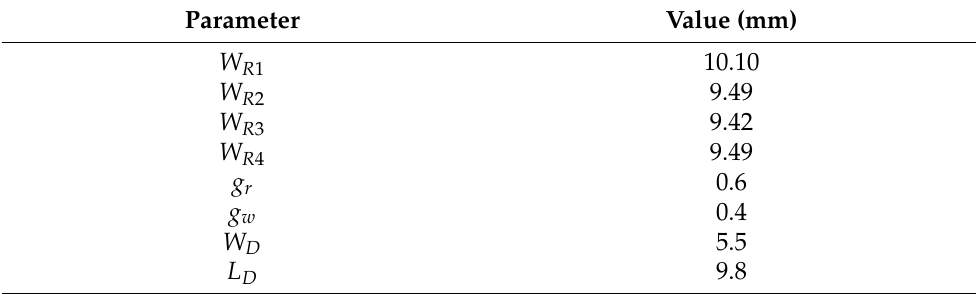
Figure 4. ( a ) Four HIS rings (innermost to outermost) and ( b ) complete HIS structure. Table 2. Optimized parameters of HIS